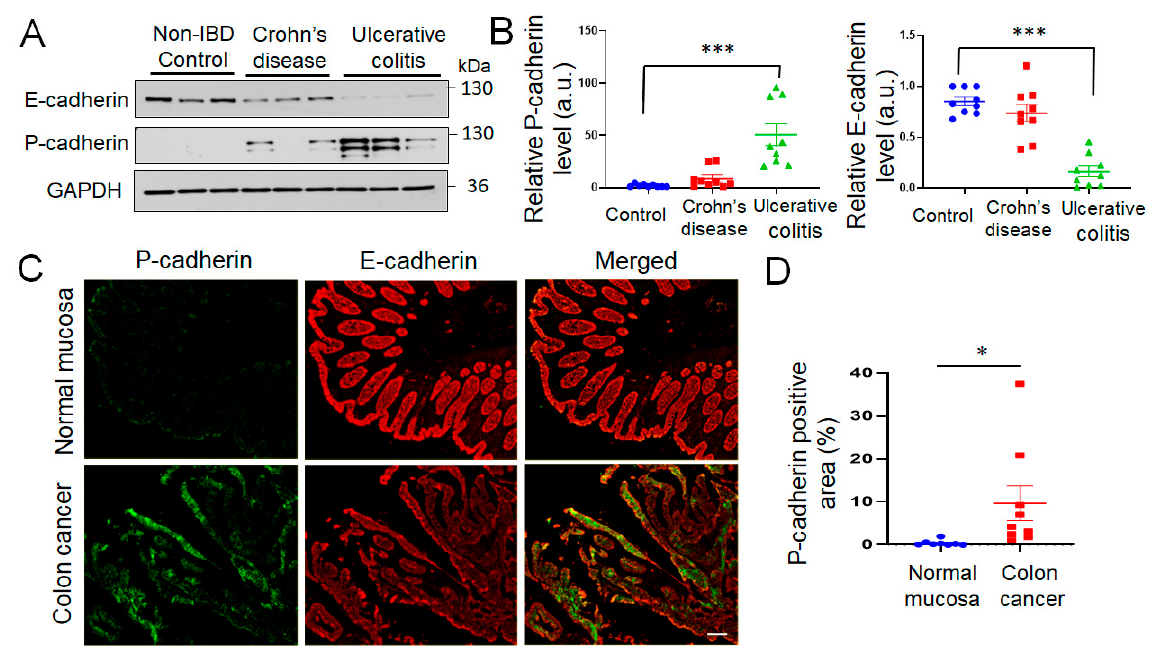
Figure 1. Increased expression of P-cadherin protein in colonic mucosa of ulcerative colitis and colitis-associated colon cancer patients. ( A , B ) Immunoblotting analysis of P-cadherin and E-cadherin expression in isolated colonic epithelial cells of Crohn’s disease, ulcerative colitis patients and non-IBD controls. Representative immunoblots ( A ) and densitometric quantification of P-cadherin and E-cadherin protein levels ( B ) are shown. Means ± SE ( n = 9 in each experimental group); *** p < 0.005. ( C , D ) Dual immunofluorescence labeling of P-cadherin (green) and E-cadherin (red) in whole thickness tissue sections of colitis-associated colon cancer patients and normal controls. Representative fluorescence microscopy images ( C ) and quantification of P-cadherin-positive area of the colonic mucosa ( D ) are shown. Means ± SE ( n = 8 and 9 for the control the CAC groups, respectively); * p < 0.05. Scale bar, 100 μ m.